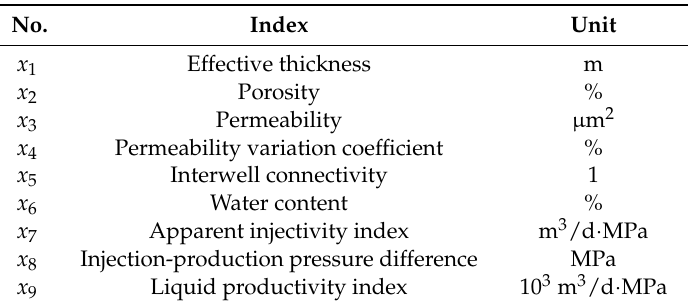
Table 2. Evaluation